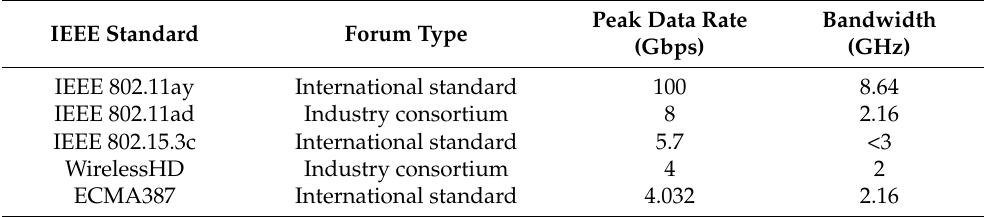
Figure 5 . Worldwide allocation of 60 GHz mmWave spectrum. Figure 5. Worldwide allocation of 60 GHz mmWave spectrum. Table 2. The 60 GHz mmWave ISM band standards suitable for indoor industrial